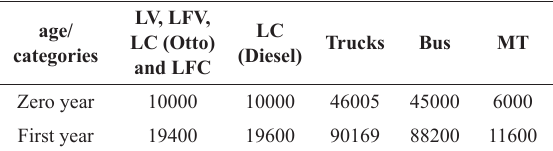
Values of use intensity for all the categories under study, corresponding to the fabrication year (zero year) and to the first year in circulation (first